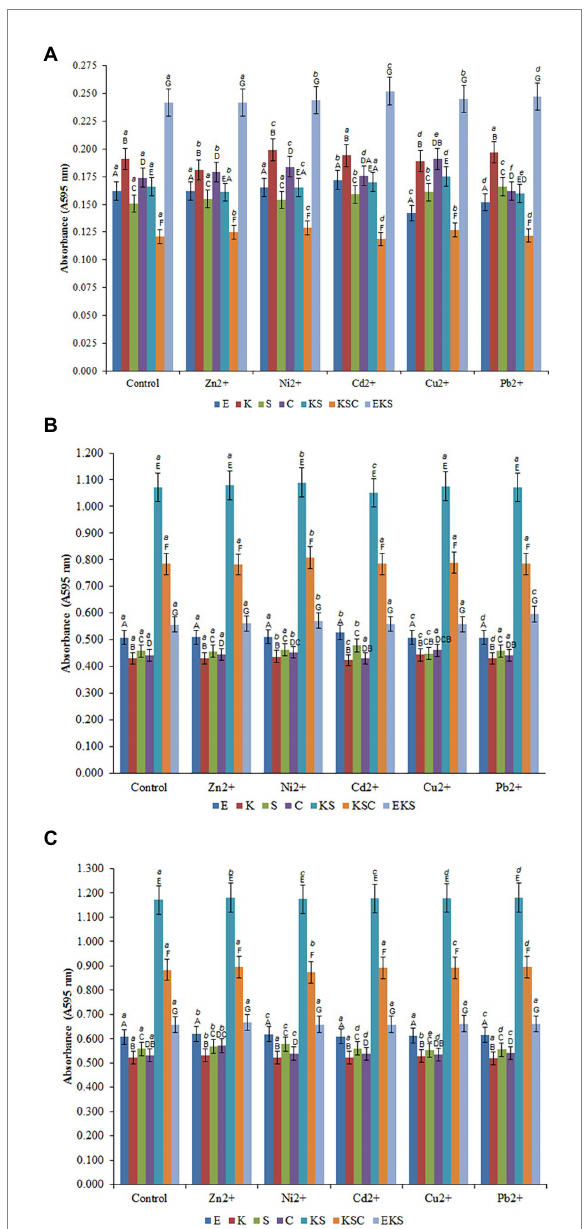
FIGURE 2 Development of the biofilms on AMB Media carriers in untreated growth control and in the presence of heavy metals after 1st (A) , 5th (B) and 10th (C) days. (E) E. cloacae , (K) K. oxytoca , (S) S. odorifera , (C) S. cerevisiae , (EK) E. cloacae/K. oxytoca , (ES) E. cloacae/S. odorifera , (EC) E. cloacae/S. cerevisiae , (KS) K. oxytoca/S. odorifera , (KC) K. oxytoca/S. cerevisiae , (EKS) E. cloacae/K. oxytoca/S.odorifera , (EKC) E. cloacae/K. oxytoca/S. cerevisiae , (KSC) K. oxytoca/S. odorifera/S. cerevisiae, (ESC) E. cloacae/S. odorifera/S. cerevisiae . All results are expressed as the mean ± SE. The statistical test was based on Wilcoxon’s test. Different capital letters above means indicate significant differences among biofilms inside treatments at a threshold of p < 0.05. Different small letters above means of biofilms among treatments are significantly different ( p <